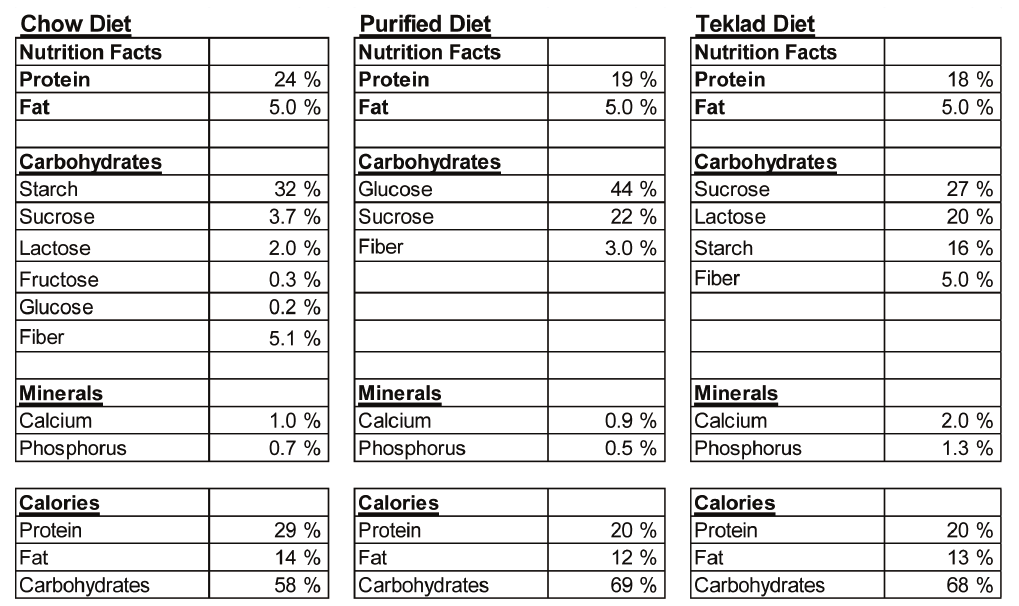
Figure 2. The nutrient composition of the diets.